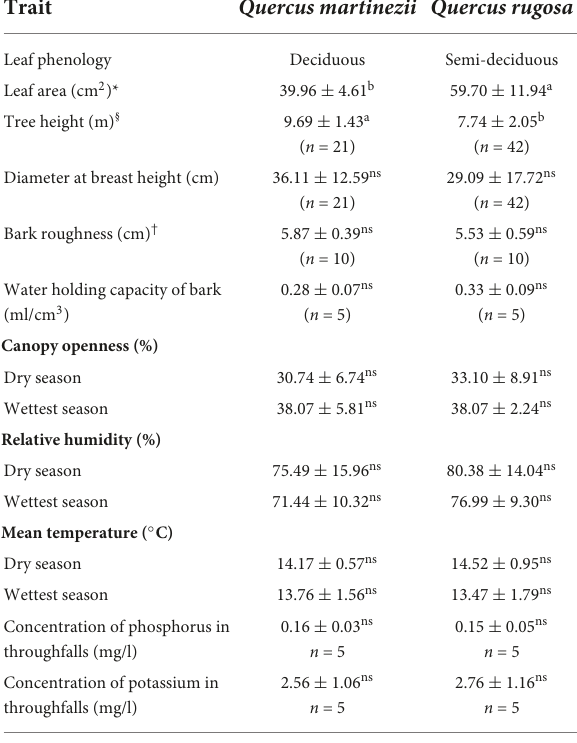
TABLE 2 Host traits of two Quercus species in a seasonal oak forest in Yanhuitlán, Oaxaca, Mexico.